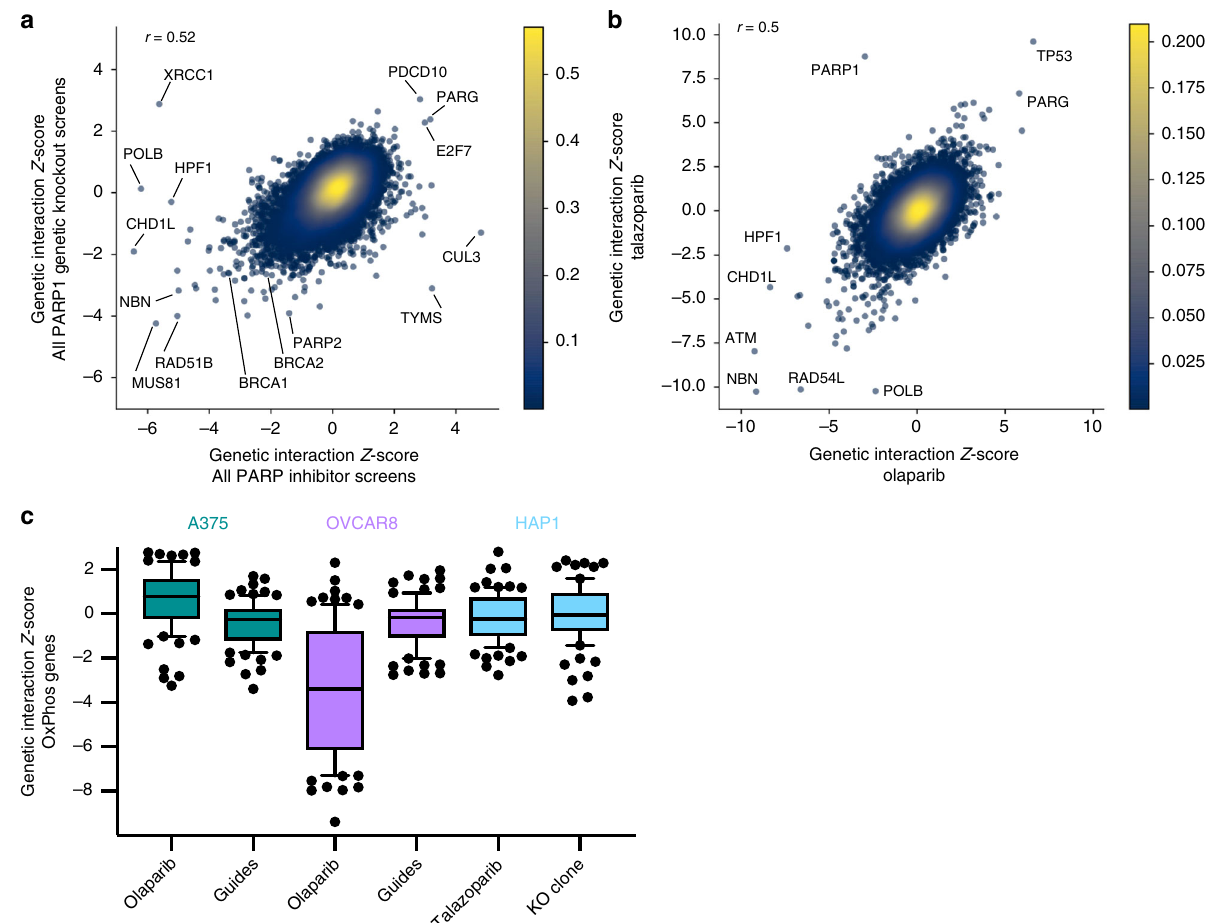
Fig. 6 Hits from PARP screens agree across contexts with some notable exceptions. a Average Z -scores for PARP inhibitors and genetic knockout perturbations, screened with the Brunello library. Points are colored by density. Pearson correlation coef fi cient is indicated. b Z -scores for olaparib and talazoparib perturbations, screened with the Gattinara library in A375 cells. Points are colored by density. Pearson correlation coef fi cient is indicated. c Box plots of Z -scores for genes in the GO gene set “ oxidative phosphorylation. ” The box represents the 25th, 50th, and 75th percentiles; whiskers show 10th and 90th